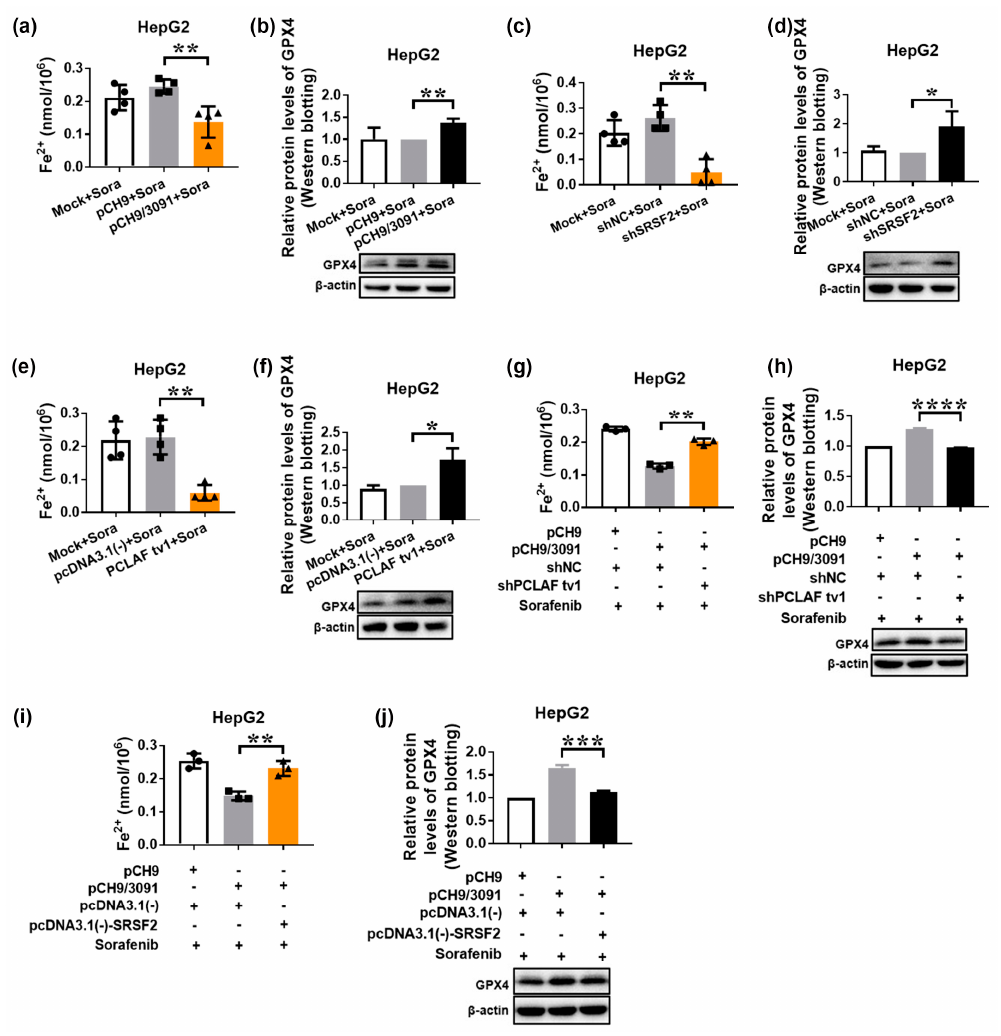
Figure 6. HBV suppresses intracellular Fe 2+ levels and induces GPX4 expression to prevent sorafenib-induced ferroptosis via the SRSF2/PCLAF tv1 pathway. HepG2 cells were transiently transfected with the indicated plasmids for 24 h before being treated with 30 μ mol/L of sorafenib for another 24 h. The Cell Ferrous Iron Colorimetric Assay Kit was used to determine the intracellular ferrous iron level ( a , c , e , g , i ). Western blotting was used to assess GPX4 expression ( b , d , f , h , j ). The graph shows the intracellular Fe 2+ levels after sorafenib treatment in pCH9 or pCH9/3091 transfected HepG2 cells. ** p < 0.005 ( a ). After sorafenib treatment, GPX4 protein levels were determined in pCH9 or pCH9/3091 transfected HepG2 cells. ** p < 0.005 ( b ). The graph shows the intracellular Fe 2+ levels after sorafenib therapy in shNC or shSRSF2 transfected HepG2 cells. ** p < 0.005 ( c ). GPX4 protein levels were measured in shNC or shSRSF2 transfected HepG2 cells after sorafenib treatment. * p < 0.05 ( d ). The graph represents the intracellular Fe 2+ levels in HepG2 cells transfected with pcDNA3.1(-) or pcDNA3.1(-)-PCLAF tv1 following sorafenib treatment. ** p < 0.005 ( e ). After sorafenib therapy, GPX4 protein levels were tested in pcDNA3.1(-) or pcDNA3.1(-)-PCLAF tv1 transfected HepG2 cells. * p < 0.05 ( f ). The graph indicates the intracellular Fe 2+ levels in HepG2 cells co-transfected with pCH9/3091 and shNC or shPCLAF tv1 after sorafenib treatment. ** p < 0.005 ( g ). After sorafenib stimulation, GPX4 protein levels were measured in pCH9/3091 and shNC or shPCLAF tv1 co-transfected HepG2 cells. **** p < 0.0001 ( h ). The graph shows the intracellular Fe 2+ levels in HepG2 cells co-transfected with pCH9/3091 and pcDNA3.1(-) or pcDNA3.1(-)-SRSF2 after sorafenib treatment. ** p < 0.005 ( i ). GPX4 protein levels were determined in pcDNA3.1(-) or pcDNA3.1(-)-SRSF2 co-transfected HepG2 cells after sorafenib treatment. *** p < 0.005 ( j ). All graphs depict the mean ± SD of at least three different tests.